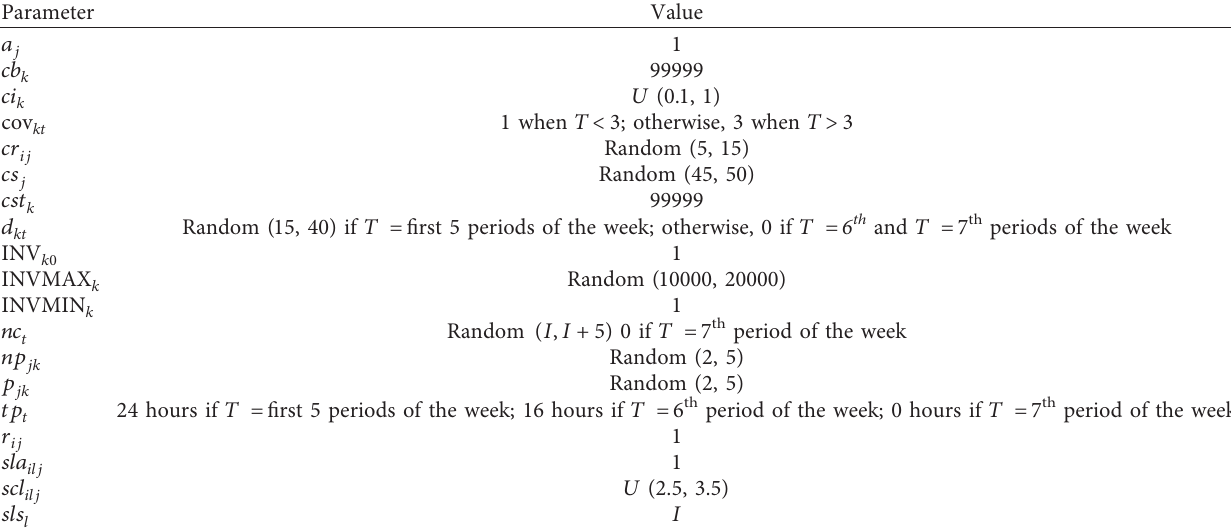
Table 5: Generation of values for data parameters.